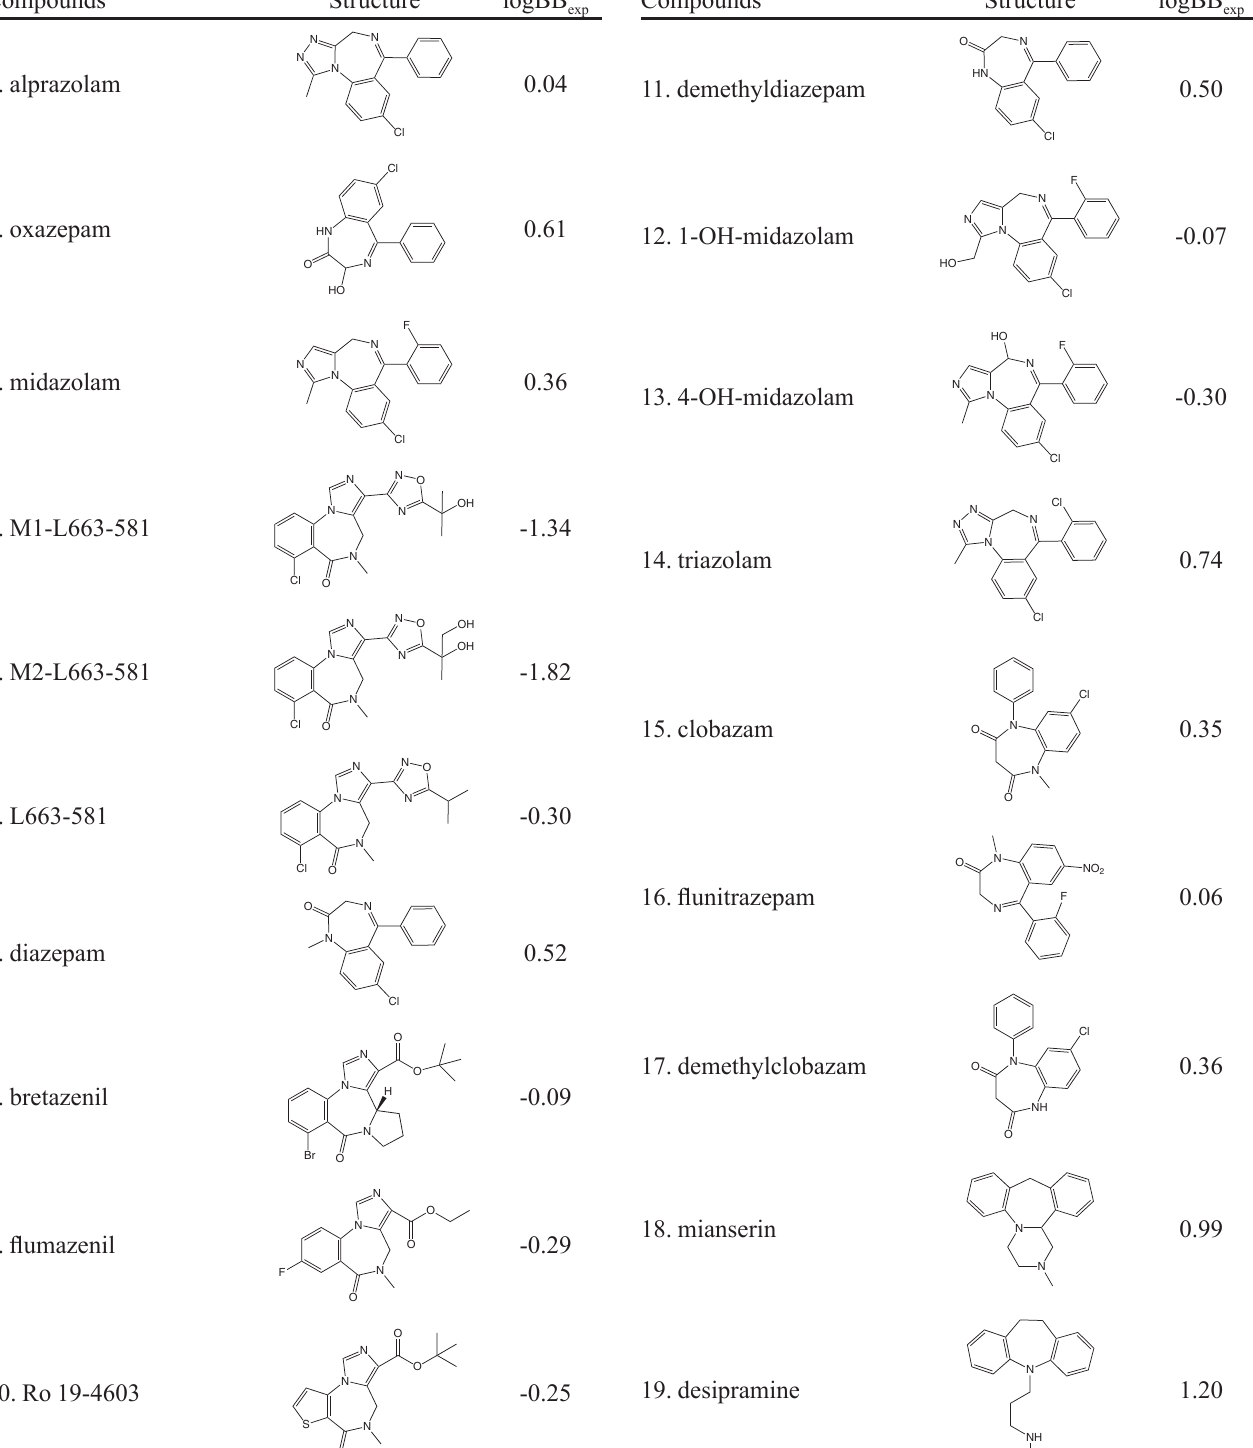
TABLE I - Chemical structures and logBB experimental values (logBBexp) found for training and test sets (Katritzky et al. , 2006). The test set compounds are marked with an asterisk